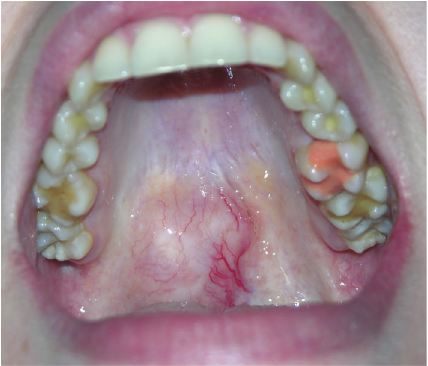
Figure 2: Pleomorphic adenoma of the junction between the soft and hard palate.